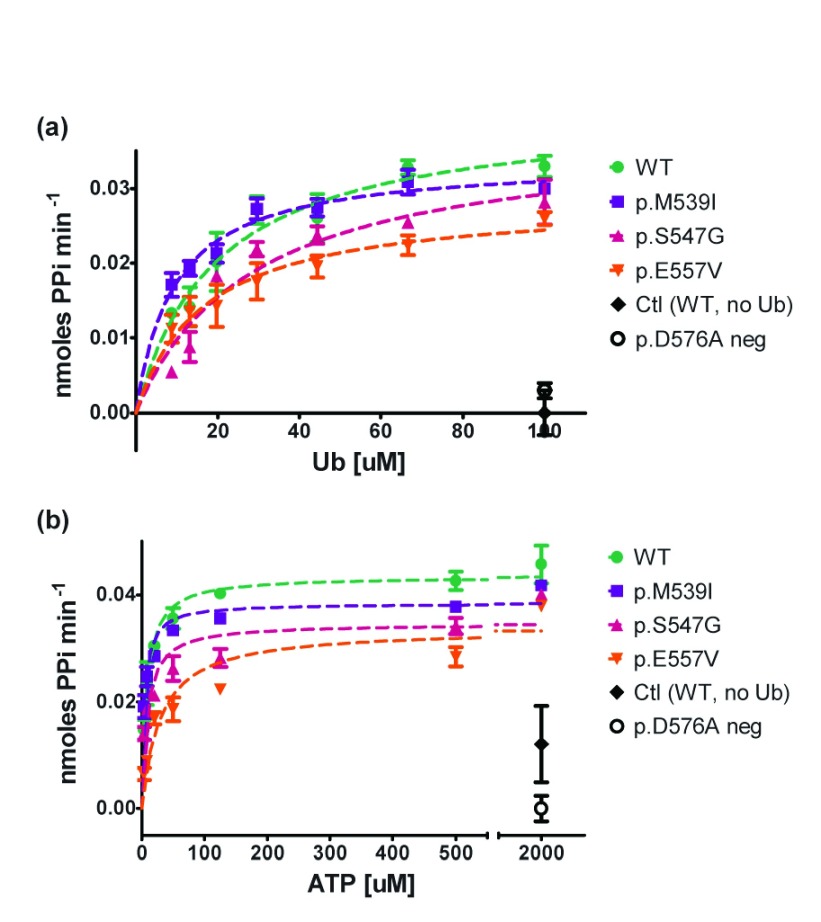
Uba1 adenylation activity as a function of Ub or ATP concentration.Kinetic assays (150µL) were run in duplicate or triplicate with 100nM WT Uba1 and XL-SMA variants in 50mM HEPES buffer at 37°C to determine initial linear rates from the first 10–20 minutes of the reaction.
A) Michaelis-Menten graph of Uba1 adenylation activity as a function of Ub concentration with saturating ATP(2000nM).
B) Michaelis-Menten graph of Uba1 adenylation activity as a function of ATP concentration with saturating Ub (100µM). Data was normalized to control reactions and graphed in GraphPad Prism. Km and Vmax values as well as 95% confidence intervals were also calculated in GraphPad Prism (see
Table 2). Only p.E557V Km (ATP) did not have overlapping confidence intervals with WT values.